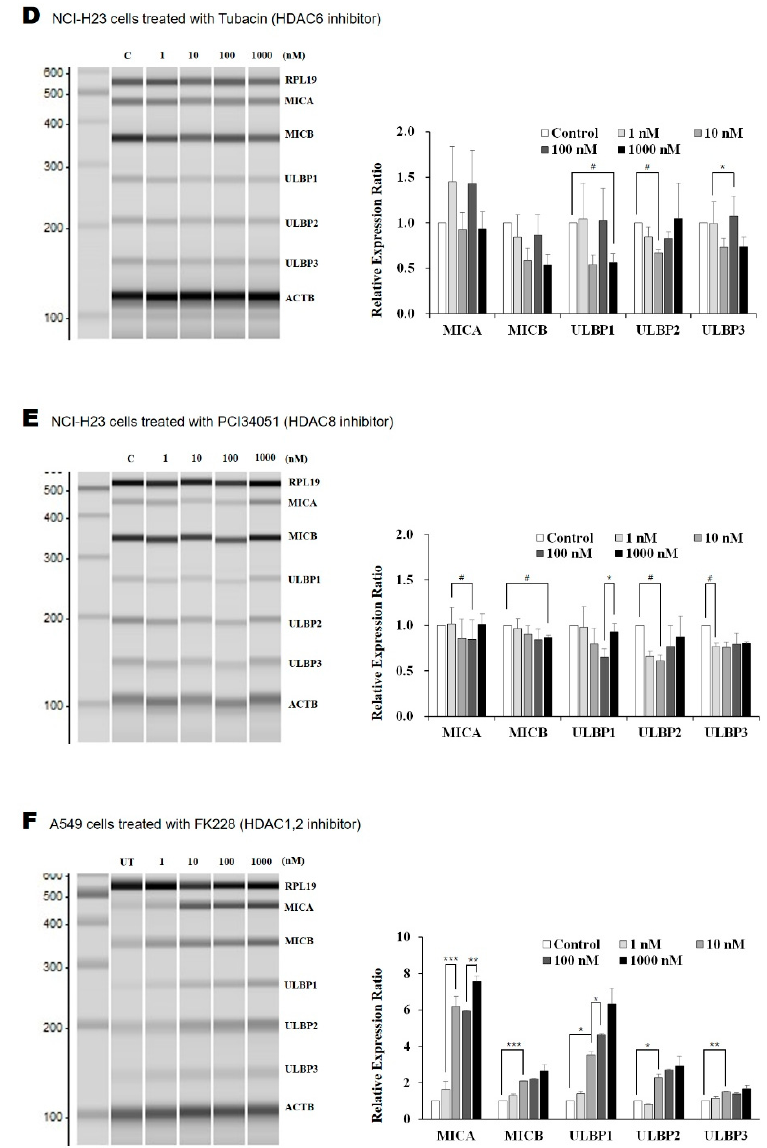
Figure 1. Altered transcription of NKG2D ligands after treatment with HDAC inhibitors. The transcription of NKG2D ligands was analyzed in lung cancer cells using multiplex RT-PCR. The NCI-H23 cells were each treated with 1, 10, 100, and 1000 nM of the following selective HDAC inhibitors: ( A ) FK228, ( B ) RGFP966, ( C ) MC1568, ( D ) Tubacin, and ( E ) PCI34051 for 18 h. ( F ) The A549 cells were treated with FK228 for 18 h. PCR products were separated and quantified using MultiNA. All experiments were performed in triplicate. Changes in transcription were normalized to the β -actin (ACTB) and presented as the mean fold change in comparison to the controls (treated with same amount of solvent, DMSO). * represents an increase, and # represents a decrease that has statistical significance. p -values less than 0.05, 0.01, and 0.001 are marked as */#, **/##, and ***,